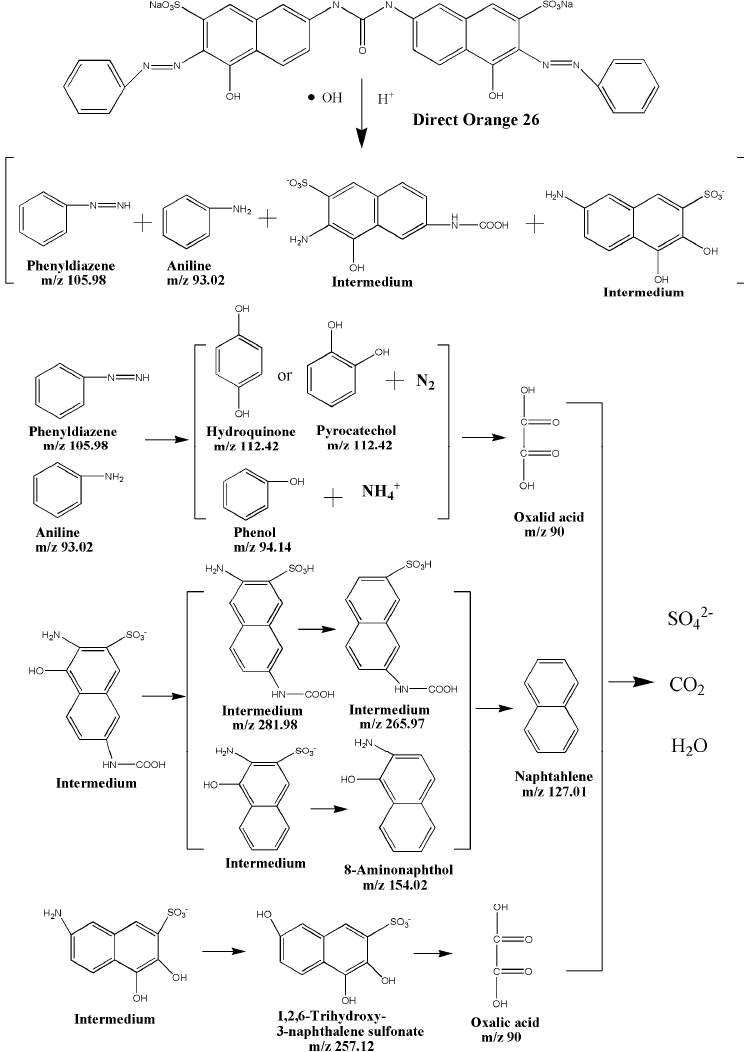
Figure 21. Suggested photocatalytic degradation pathway scheme for Direct Orange 26 under visible light irradiation with BiGdO 3 as catalyst.